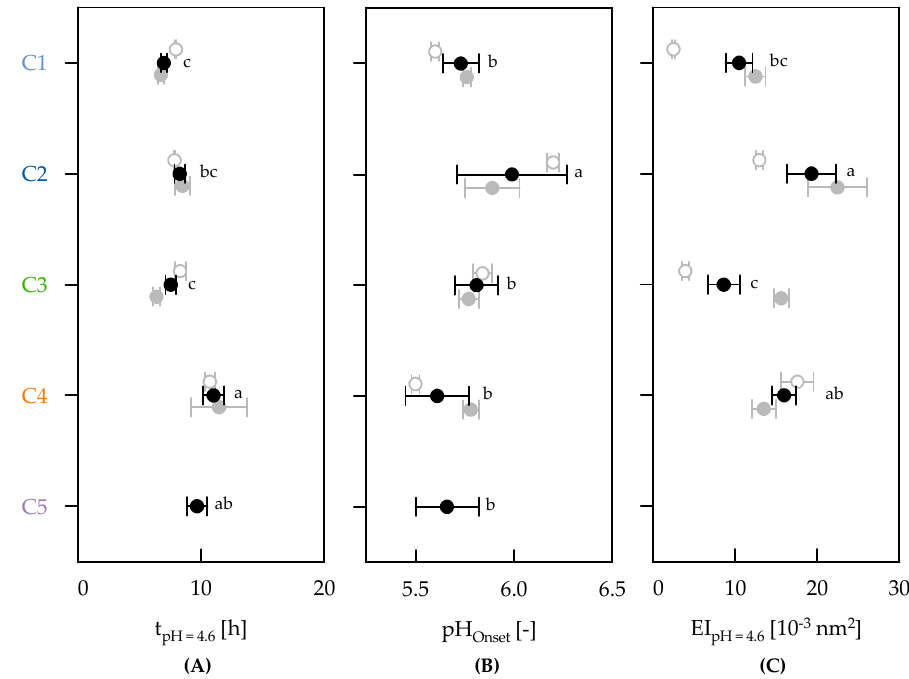
Figure 4. Cluster ‐ specific average time until pH 4.6 (t pH = 4.6 ) ( A ), pH at gelation onset (pH Onset ) ( B ) and elasticity index at pH 4.6 (EI pH = 4.6 ) (black, C ). Mean values in the same plot with different superscripts differ significantly at p < 0.10. To study the influence of cell ‐ bound EPS (cEPS), data is also displayed for non ‐ cEPS (grey, open) and cEPS producers (grey, closed). EI pH = 4.6 of C5 is not included due to gel shrinkage. Bars indicate standard error of the mean.